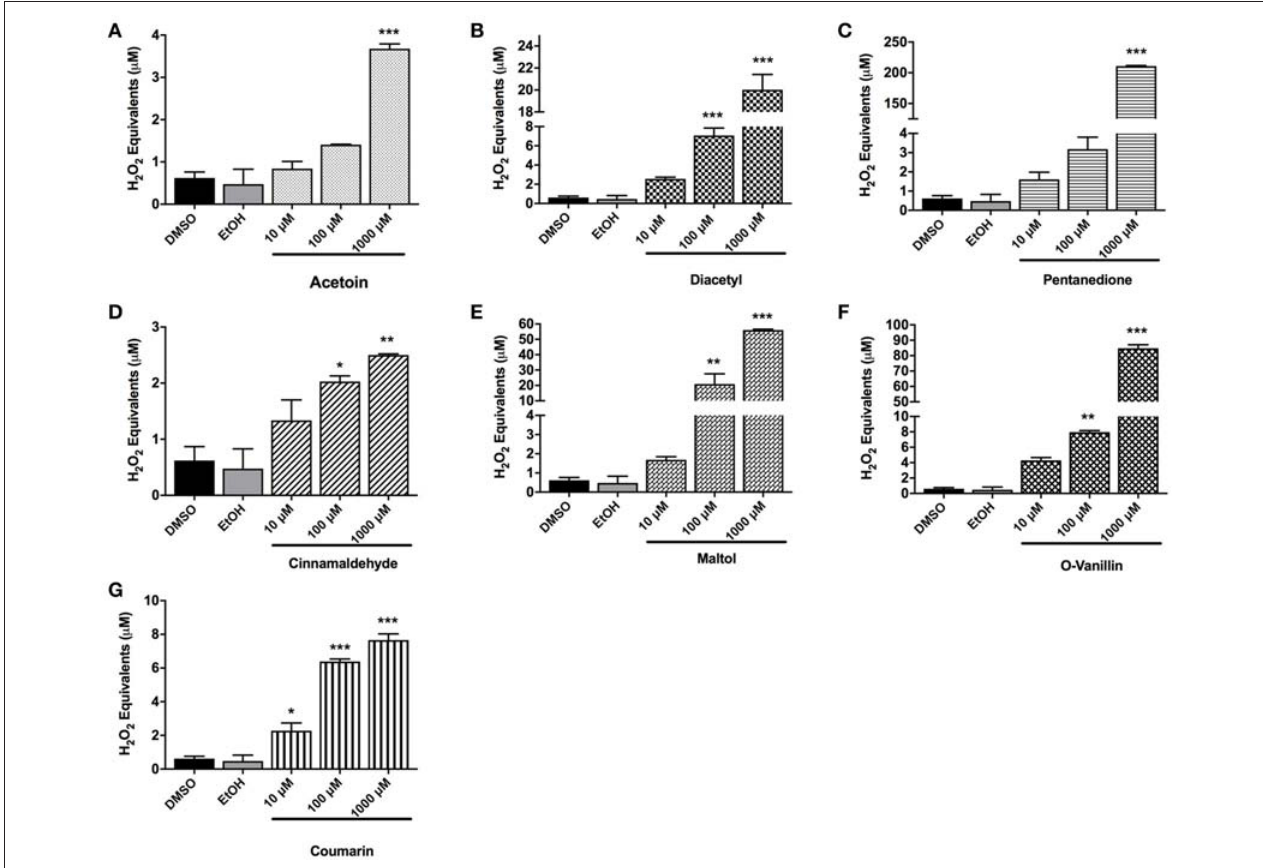
FIGURE 4 | Cell-free ROS in flavoring chemicals. (A) Acetoin, (B) diacetyl, (C) pentanedione, (D) cinnamaldehyde, (E) maltol, (F) o-vanillin, and (G) coumarin flavoring chemicals were added to DCFH OX/ROS indicator solution at 10 μ M, 100 μ M, and 1,000 μ M concentrations. Oxidized DCF fluorescence was measured using a fluorometer. Data are shown as mean ± SEM ( n = 2–3 per group). Statistical significance was determined by one-way ANOVA statistical analysis (Tukey’s multiple comparisons test). * P < 0.05, ** P < 0.01, *** P < 0.001, vs. DMSO and